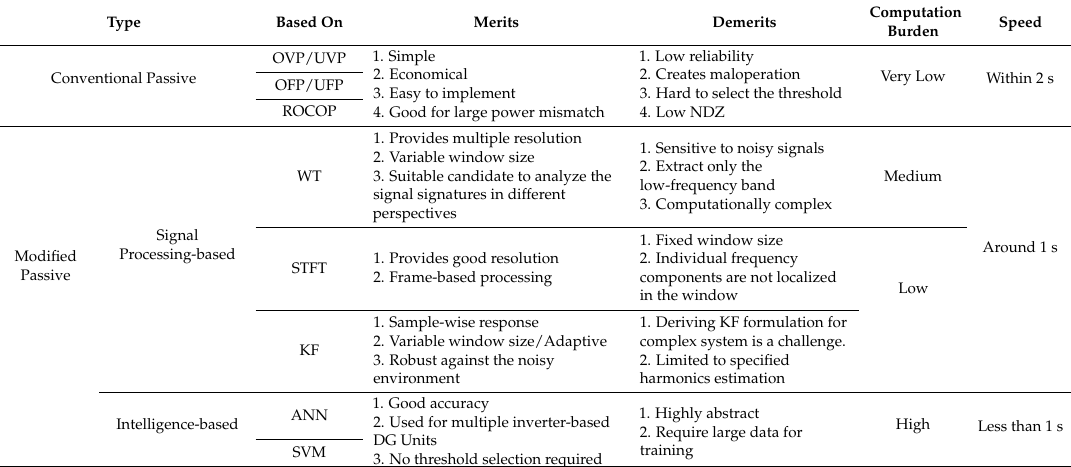
Table 3. Comparison of Various IdMs